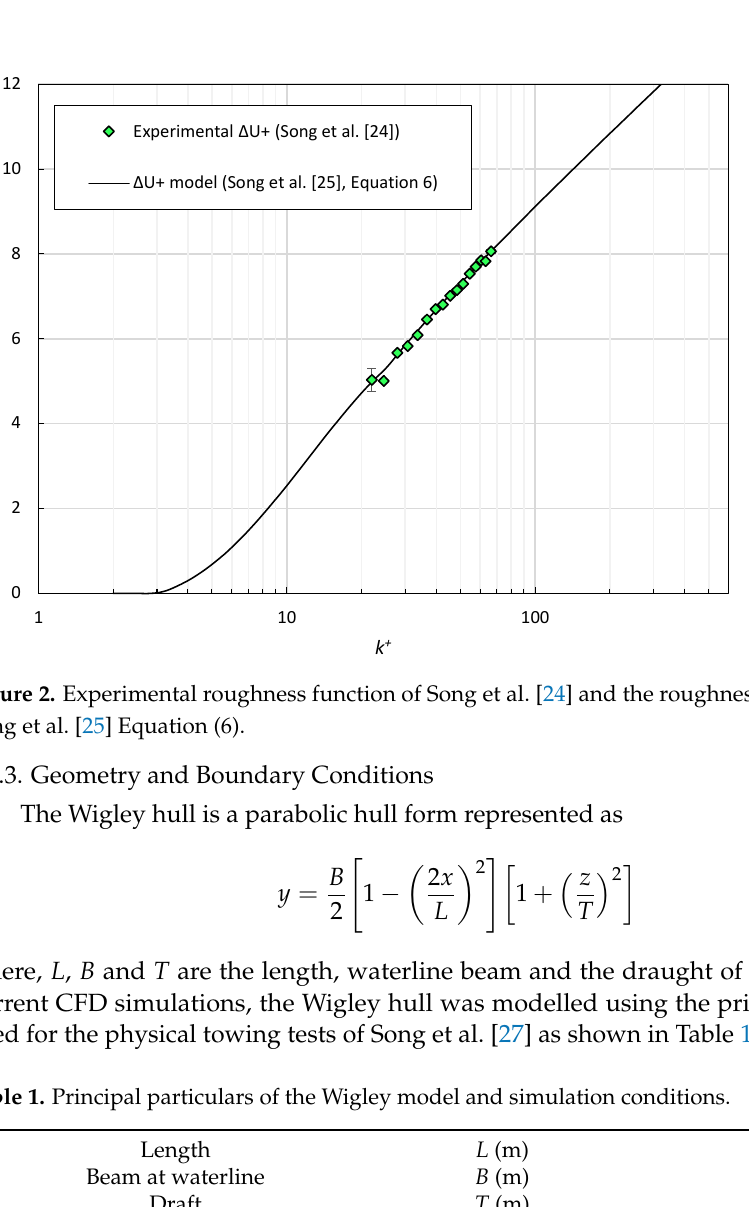
Table 1. Principal particulars of the Wigley model and simulation conditions.